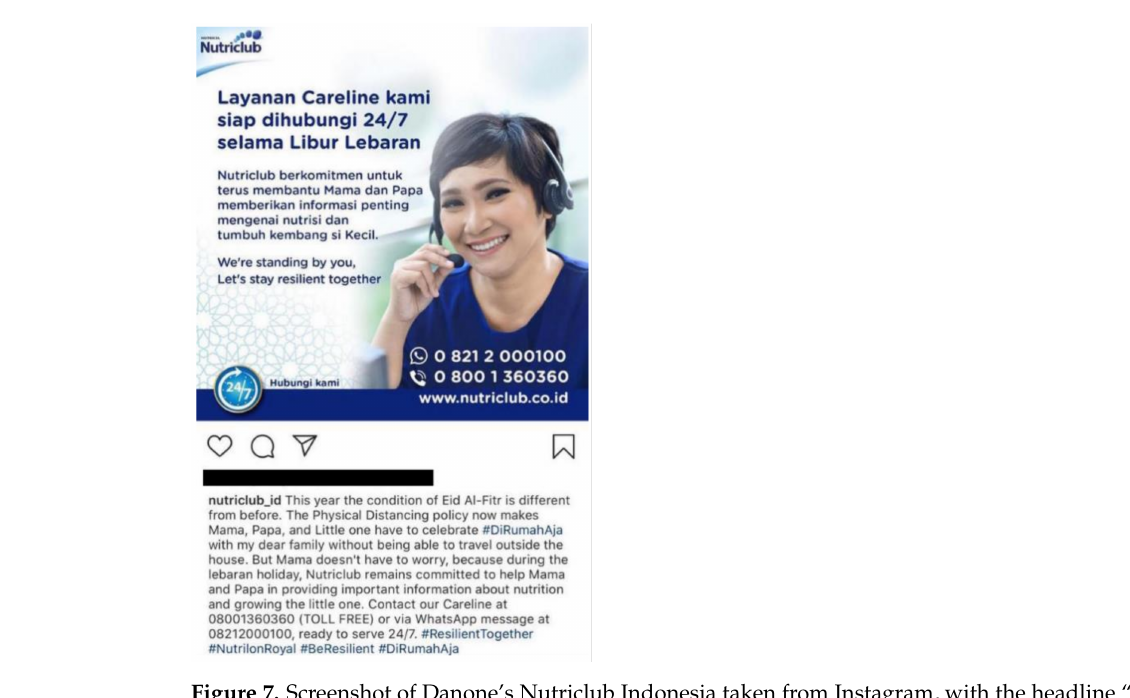
Figure 7. Screenshot of Danone’s Nutriclub Indonesia taken from Instagram, with the headline “Our careline services are available 24/7 during the Eid holidays” (translated from